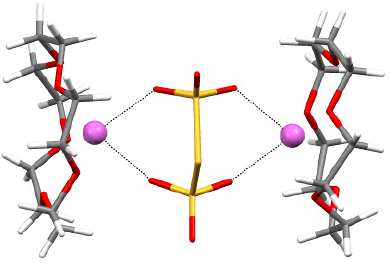
Figure 9. XRD structure of salt [Na(15-crown-5)] salt 70b